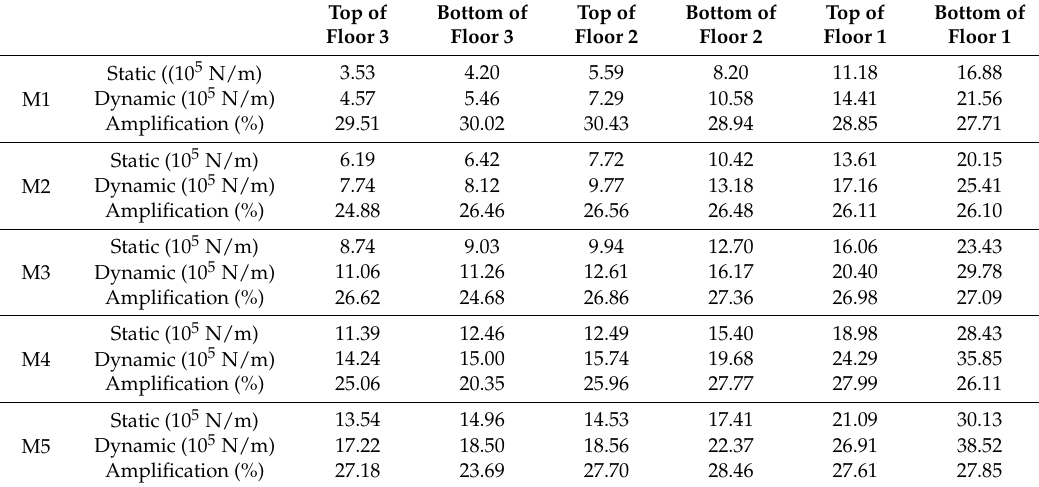
Table 14. Shear forces of internal side wall 3 in different buried depths.